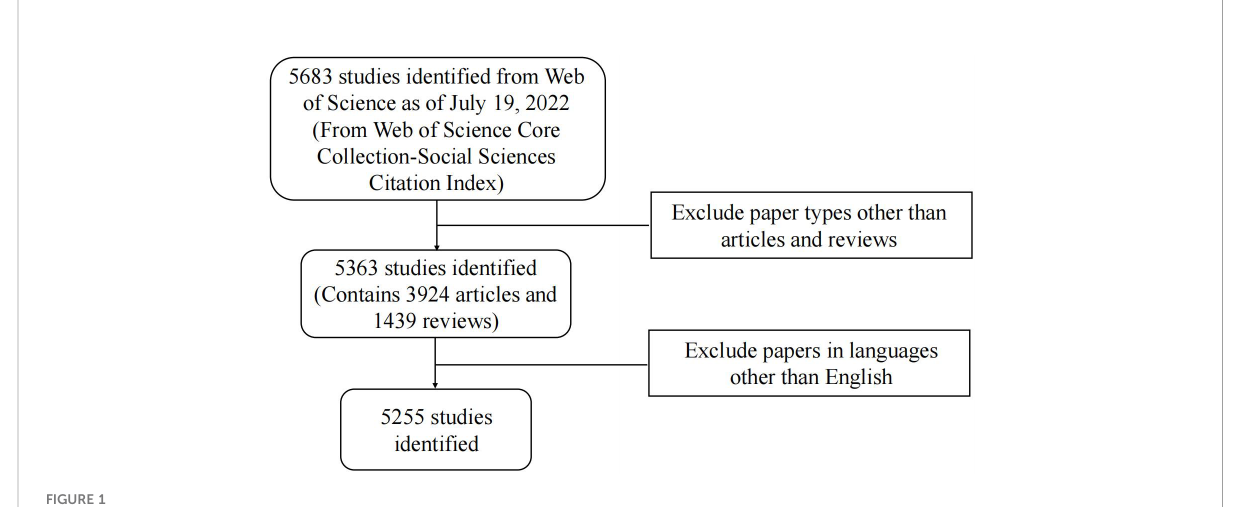
FIGURE 1 Study fl ow